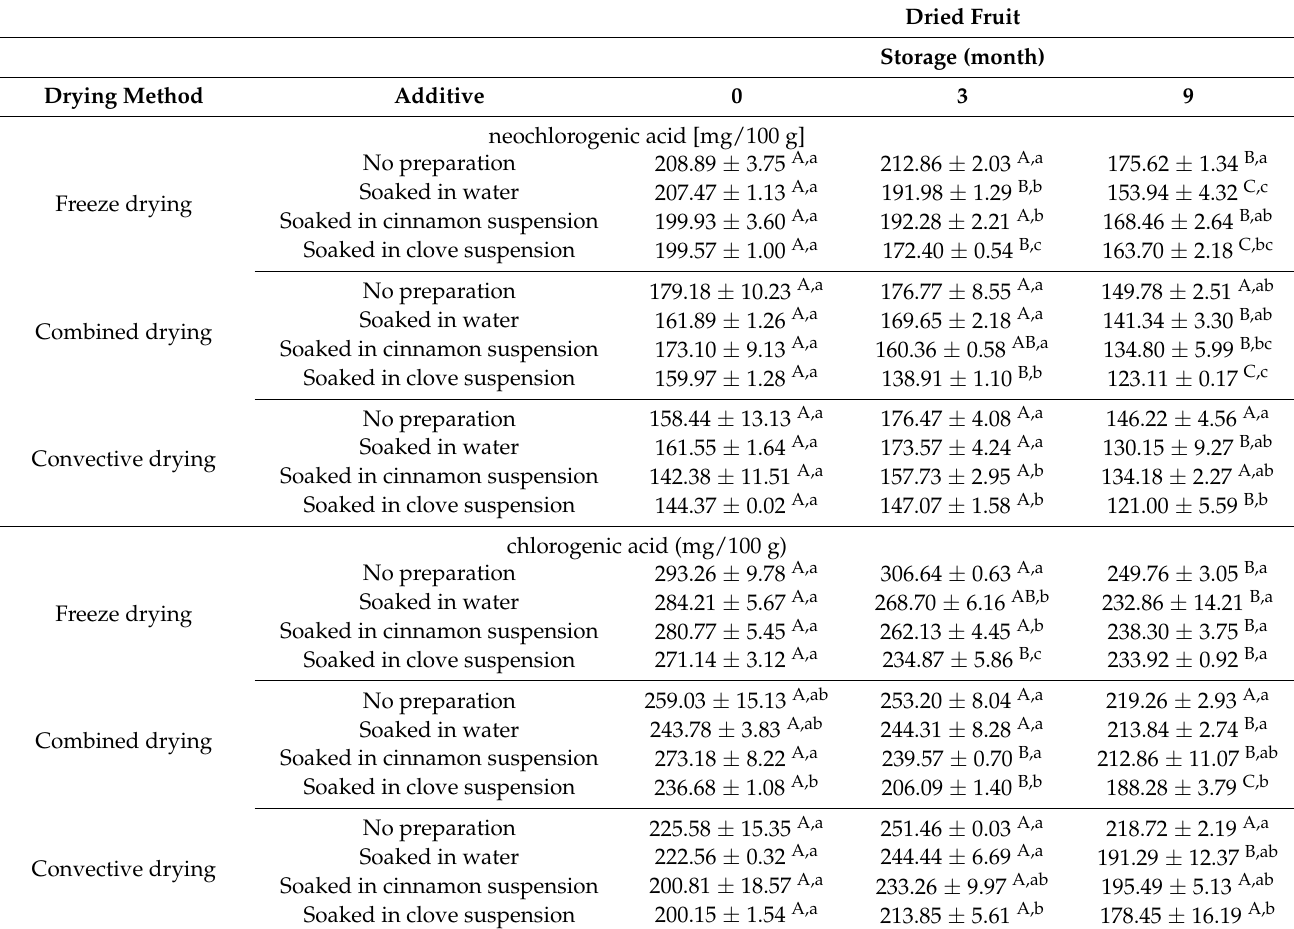
Table 2. Changes in phenolic acids content during storage of tested black chokeberry fruits.